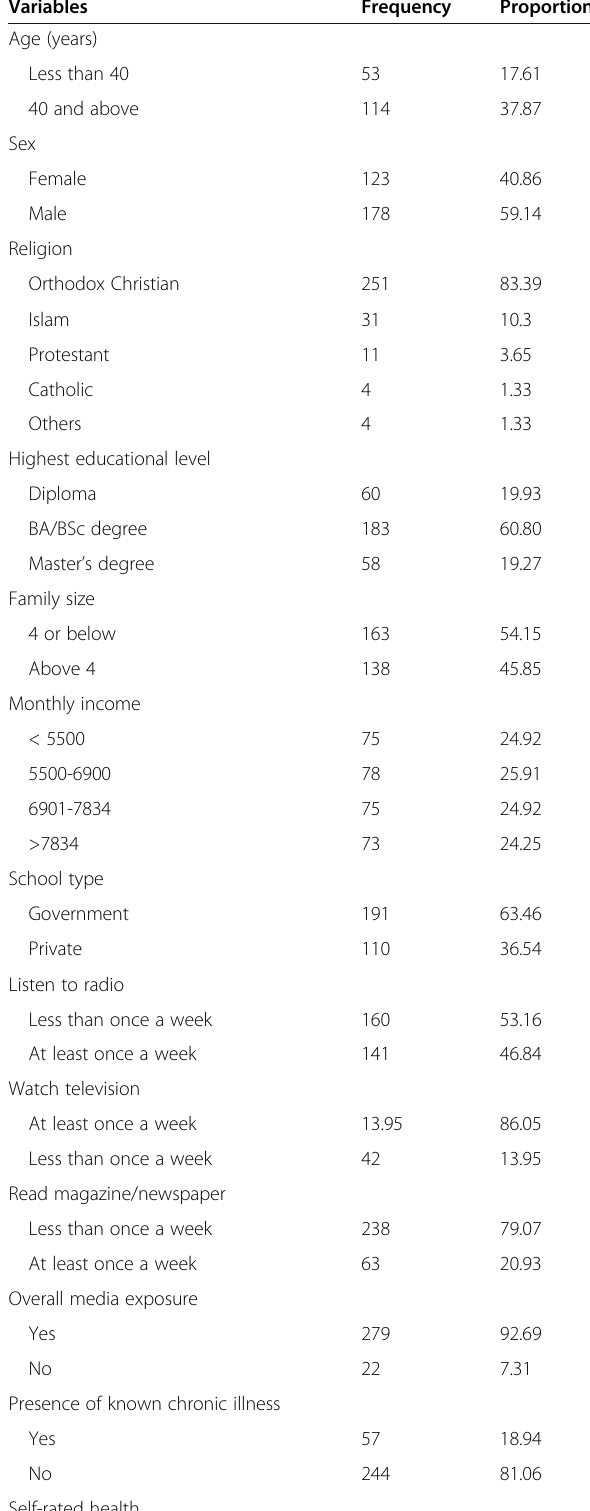
Table 1 Sociodemographic characteristics of school teachers in Gondar City, Northwest, Ethiopia (n = 301)